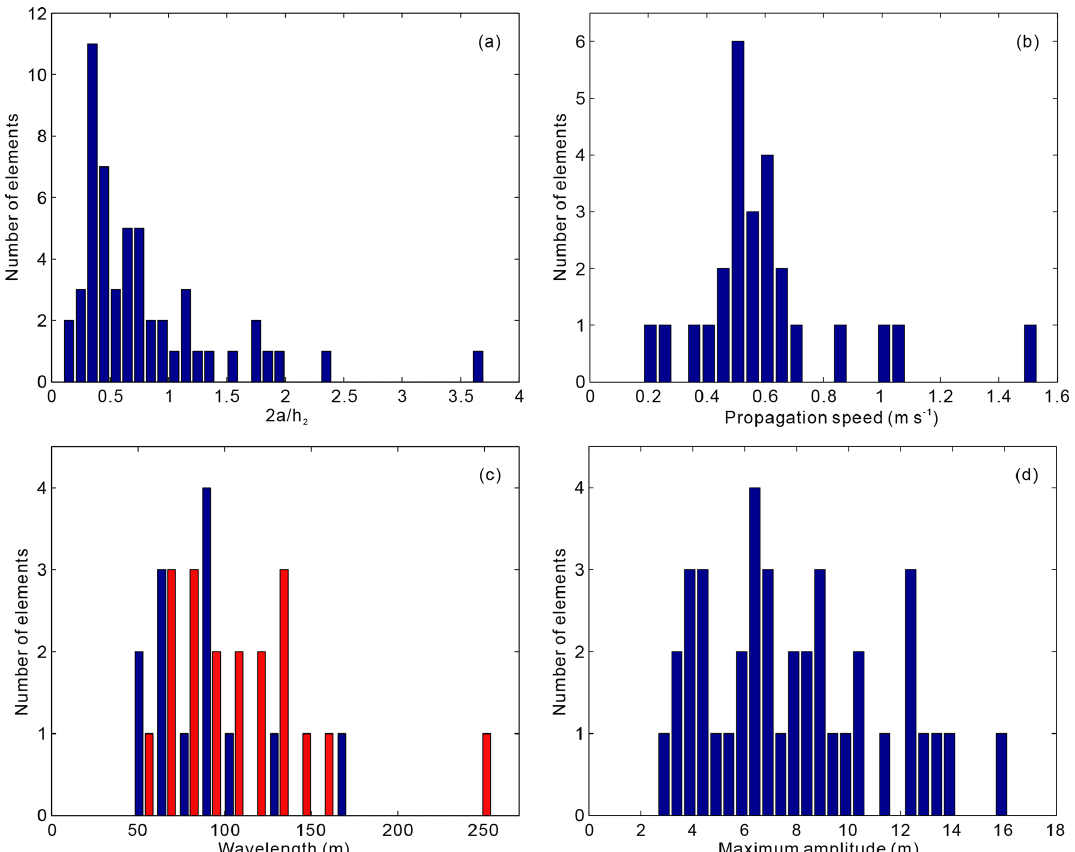
Figure 6. (a) Histogram of the dimensionless amplitude of the mode-2 ISW in the study area. (b) Histogram of the propagation speed of the mode-2 ISW in the study area. (c) Histogram of the wavelength of the mode-2 ISW in the study area. The dark blue and red bars denote the ISWs on the survey lines in the SW–NE and NE–SW directions, respectively. (d) Histogram of the maximum amplitude of the mode-2 ISW in the study